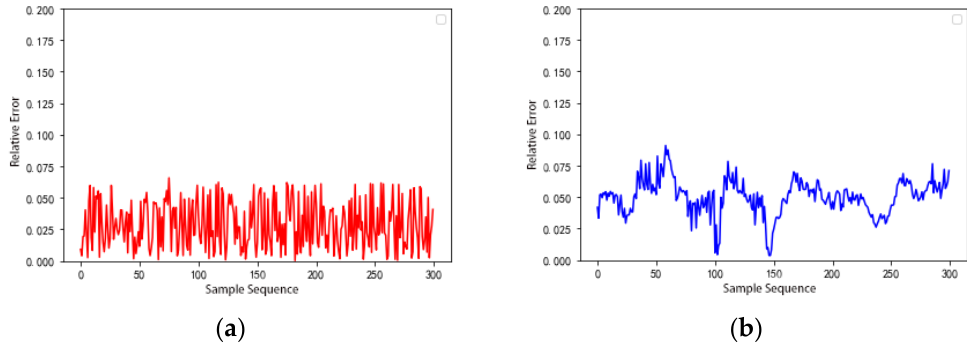
Figure 9. ( a ) Estimated error of test data. ( b ) Estimated error of test data.